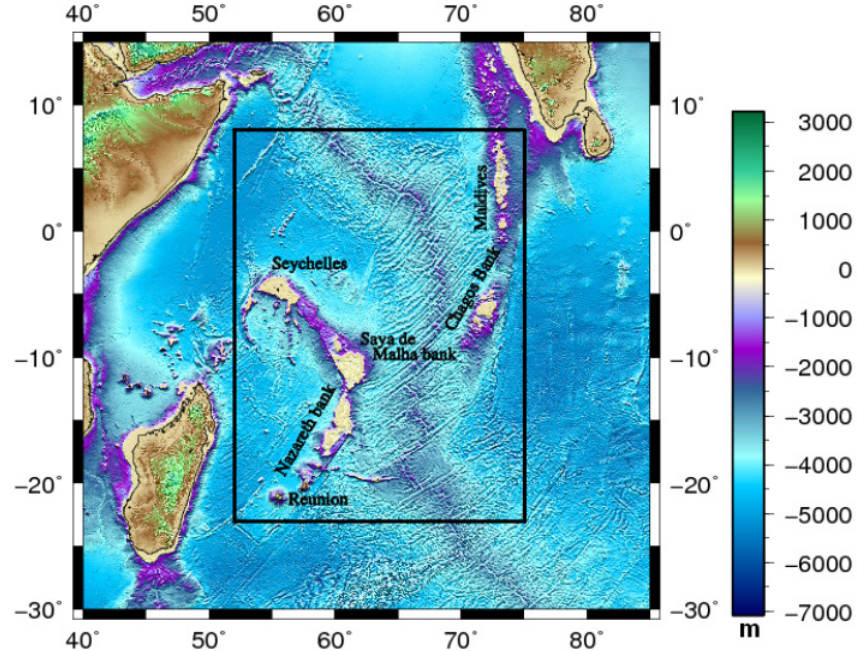
Figure 1. Bathymetry map of the study area, with the major tectonic features shown. The black rectangle indicates the area over which the calculations were performed. The locations of Réunion, Chagos Bank and Maldives (short name of Chagos–Maldives–Laccadives Ridge), and Saya de Malha Bank, Nazareth Bank and the Seychelles are